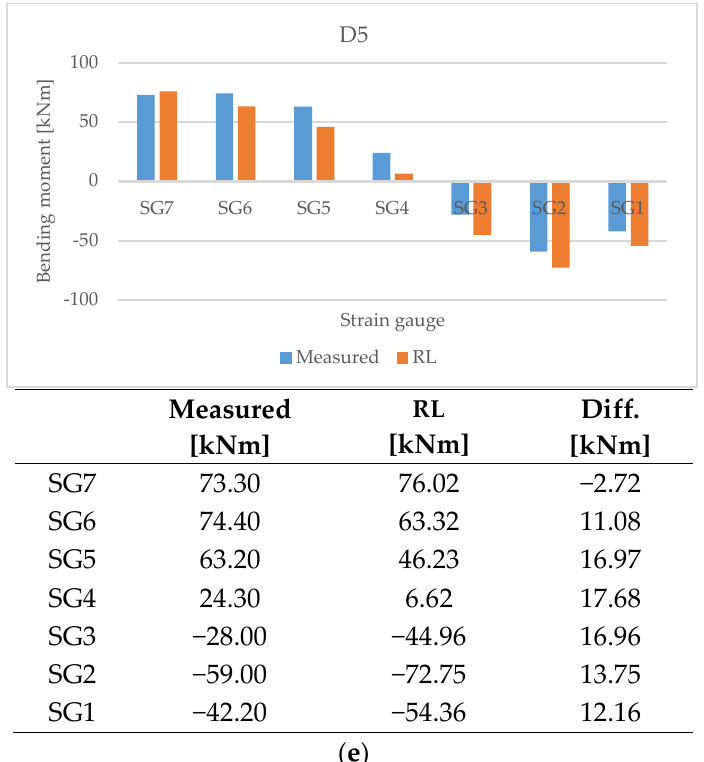
Figure 23. Comparison of predicted strain gauge bending moment with measurements of ( a ) D1, ( b ) D2, ( c ) D3, ( d ) D4, and ( e ) D5.